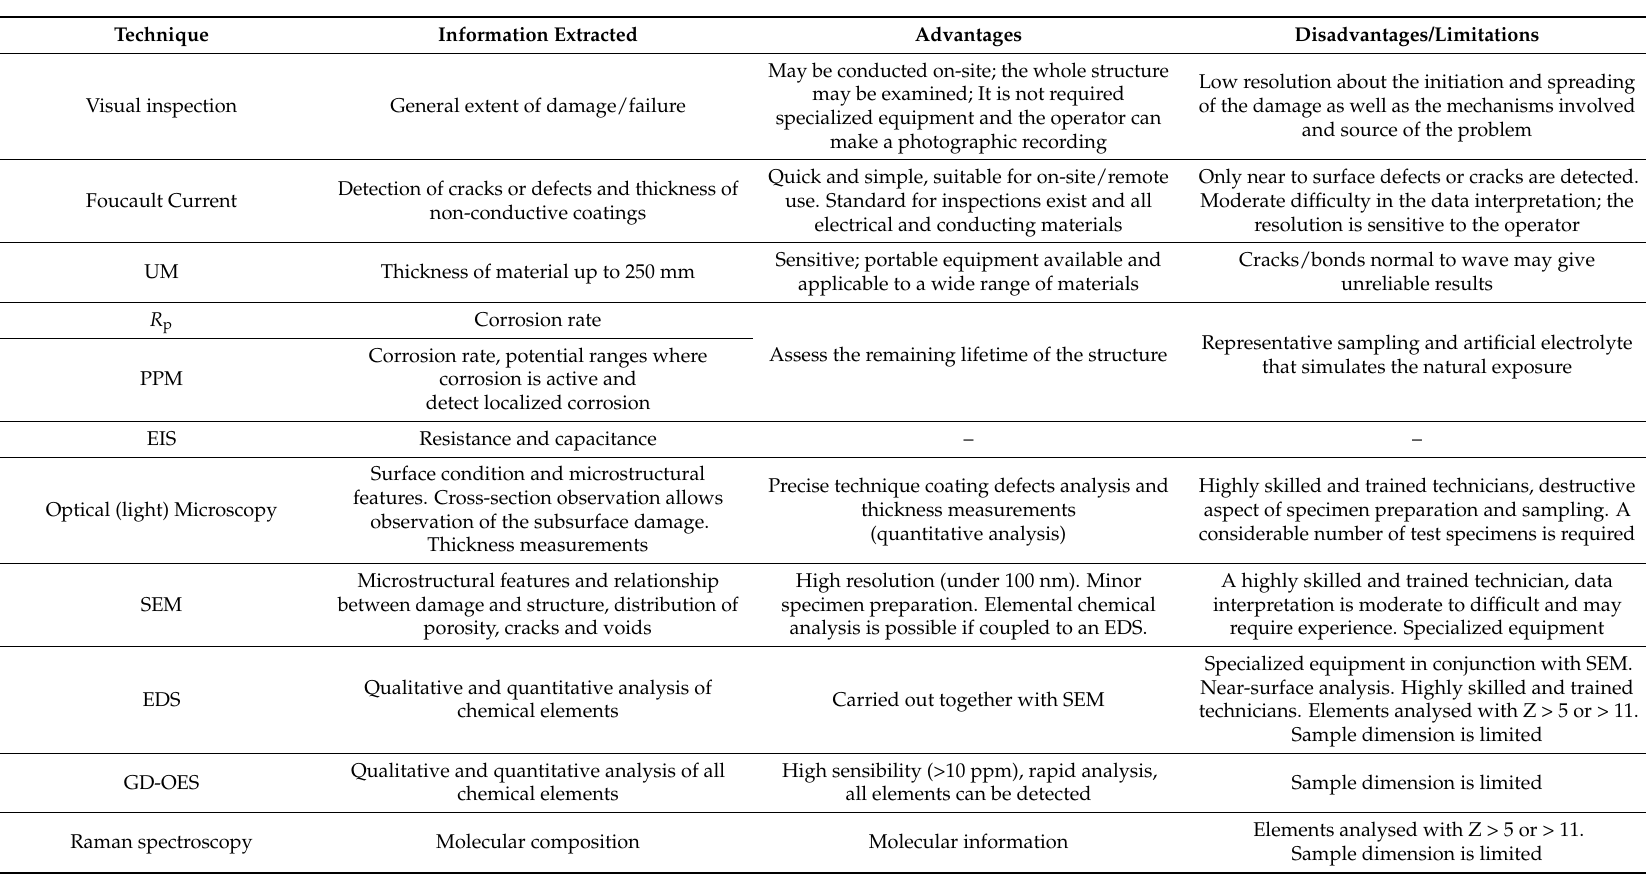
Table 13. Summary of techniques discussed in the previous